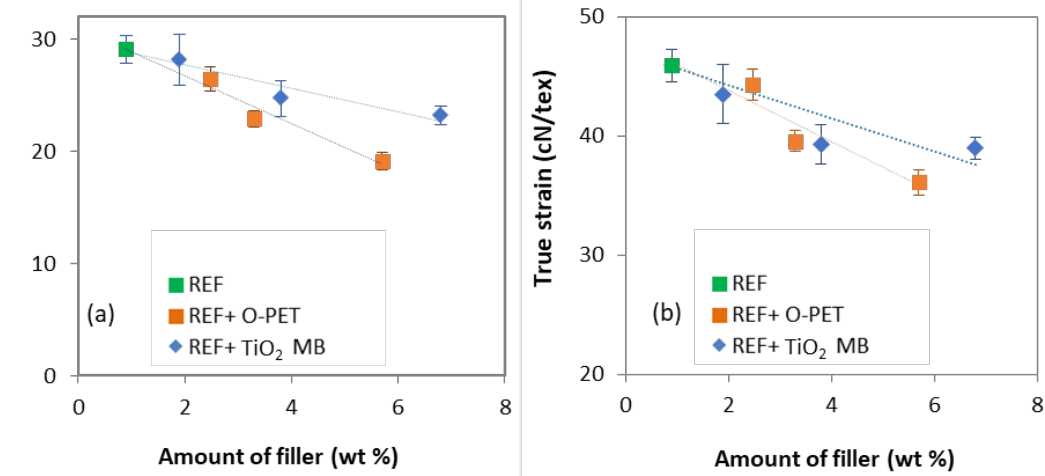
Figure 9. ( a ) Tenacity and ( b ) true strain versus the amount of filler for the two sets of filaments.